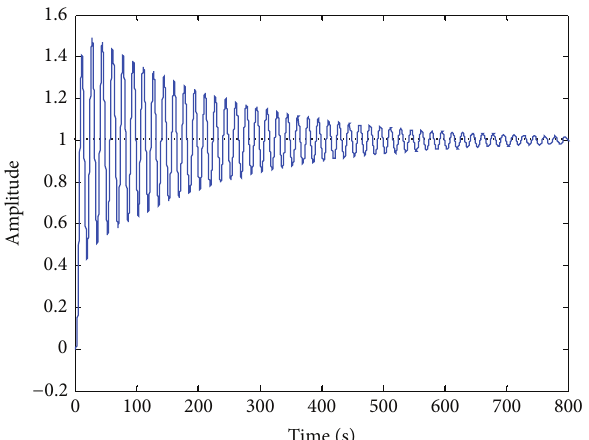
Figure 10: Lateral deviation step response (incorrect order reduc- tion).